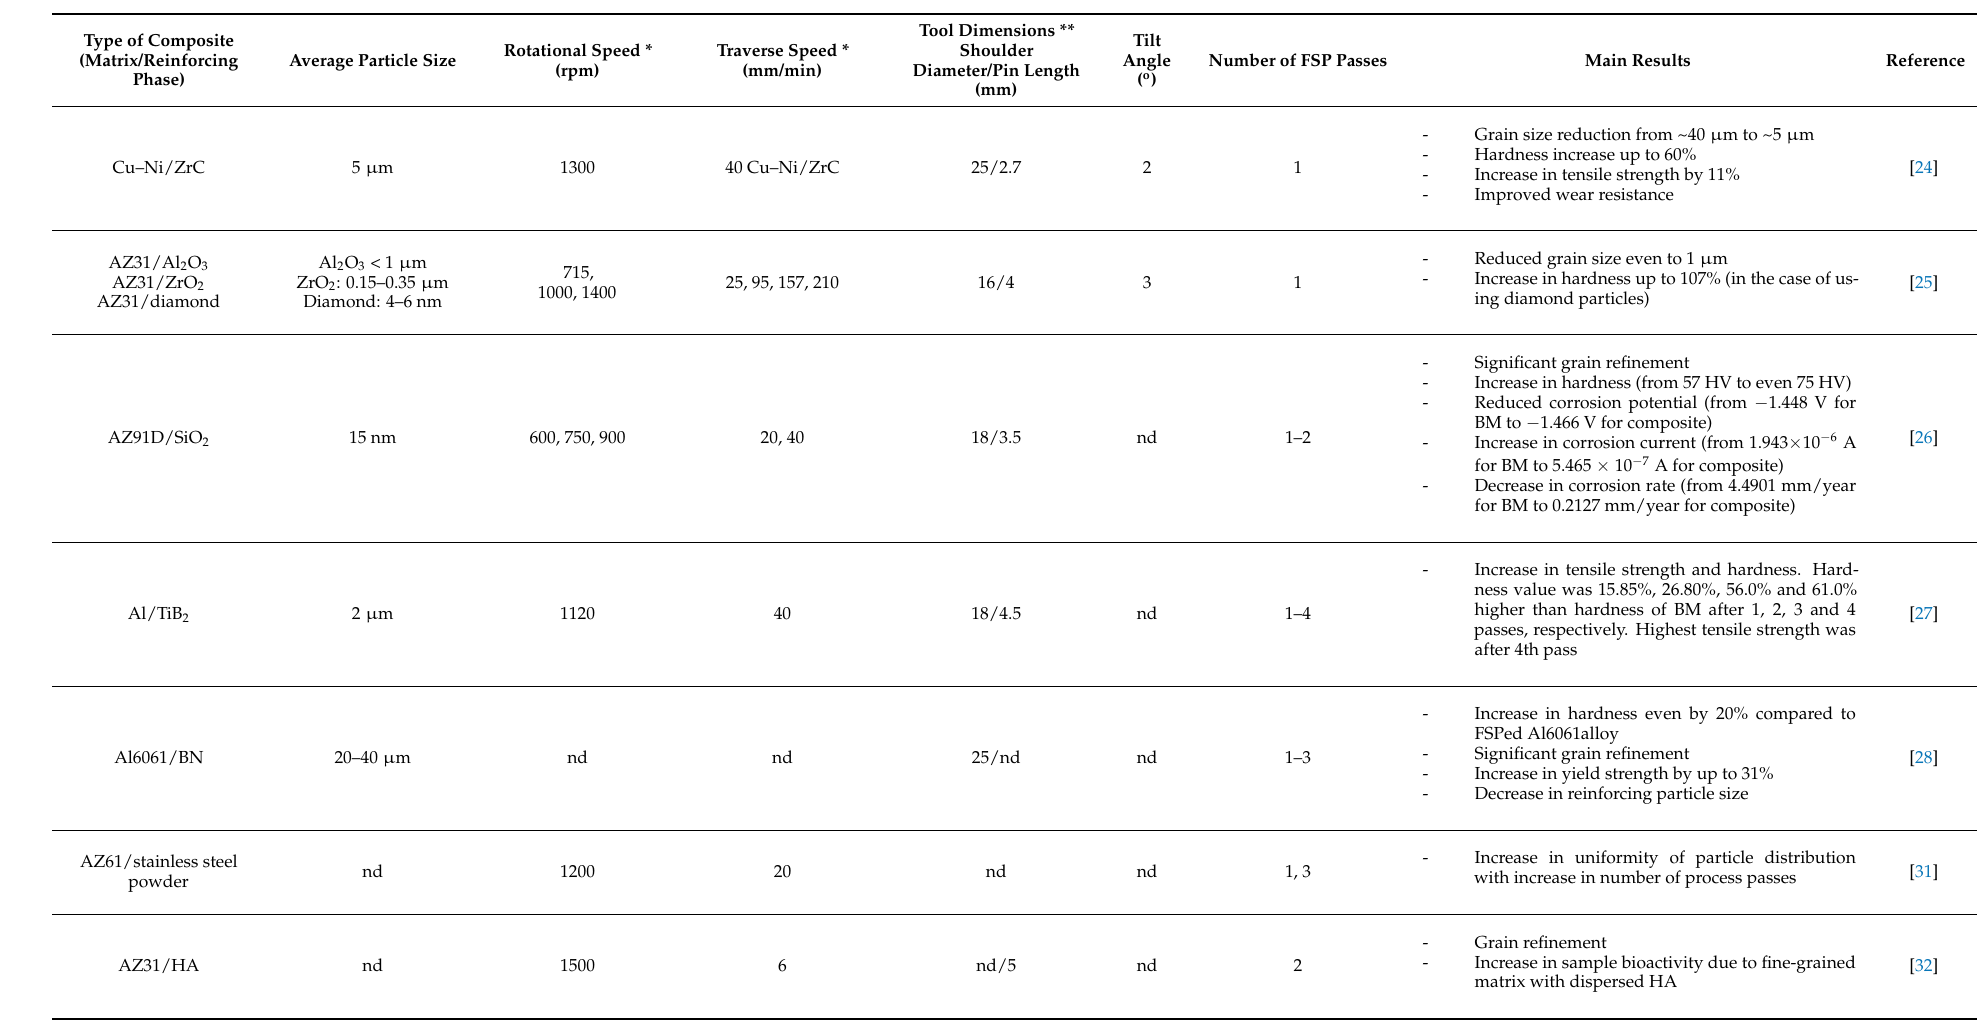
Table 1. List of cited